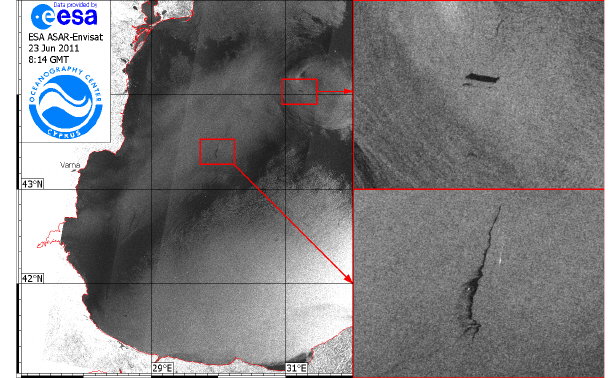
Fig. 8. Satellite image of the Black Sea on 23 June 2011, with two oil